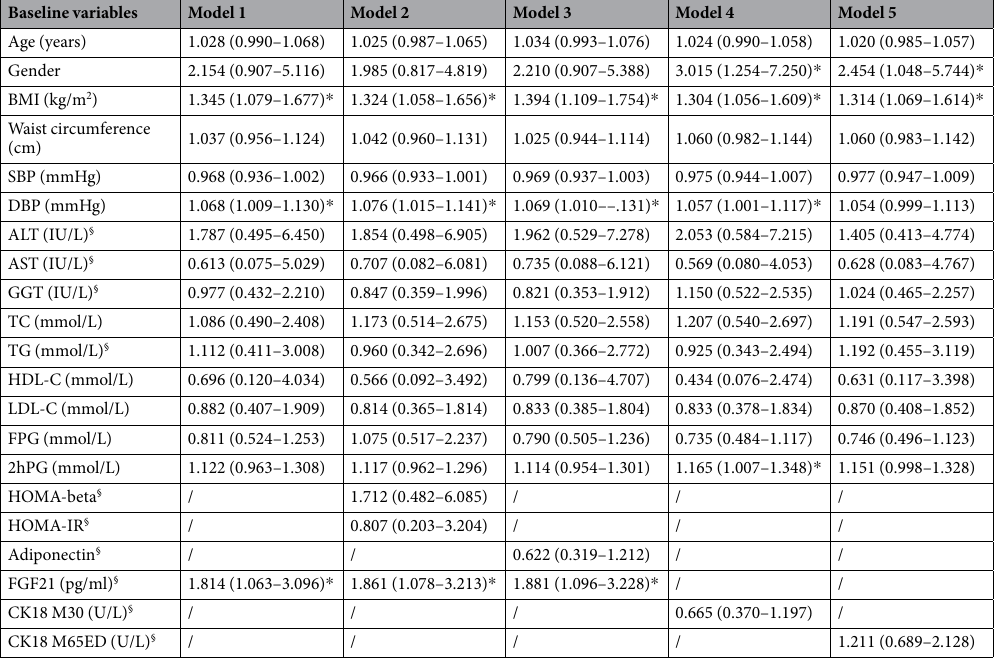
Table 2. Baseline parameters predictive of the onset of simple steatosis at 3 years, examined using multiple logistic regression. Data are odds ratio (OR) (95%CI). § Ln transformed before analysis. * P < 0.05. Model 1. Included baseline risk factors (age, gender, BMI, waist circumference, SBP, DBP, ALT, AST, GGT, TG, TG, HDL- C, LDL-C, FPG and 2hPG), and FGF21. Model 2 Included baseline risk factors, HOMA-beta, HOMA-IR, and FGF21. Model 3 Included baseline risk factors, adiponectin, and FGF21. Model 4 Included baseline risk factors and CK18 M30. Model 5 Included baseline risk factors and CK18